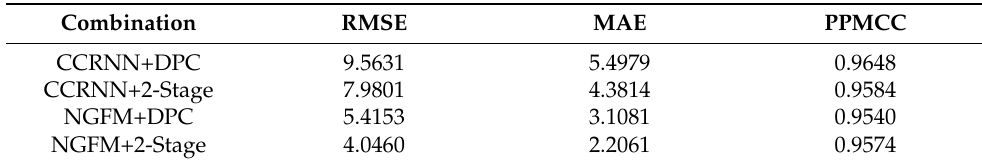
Table 2. Two-stage clustering algorithm effectiveness